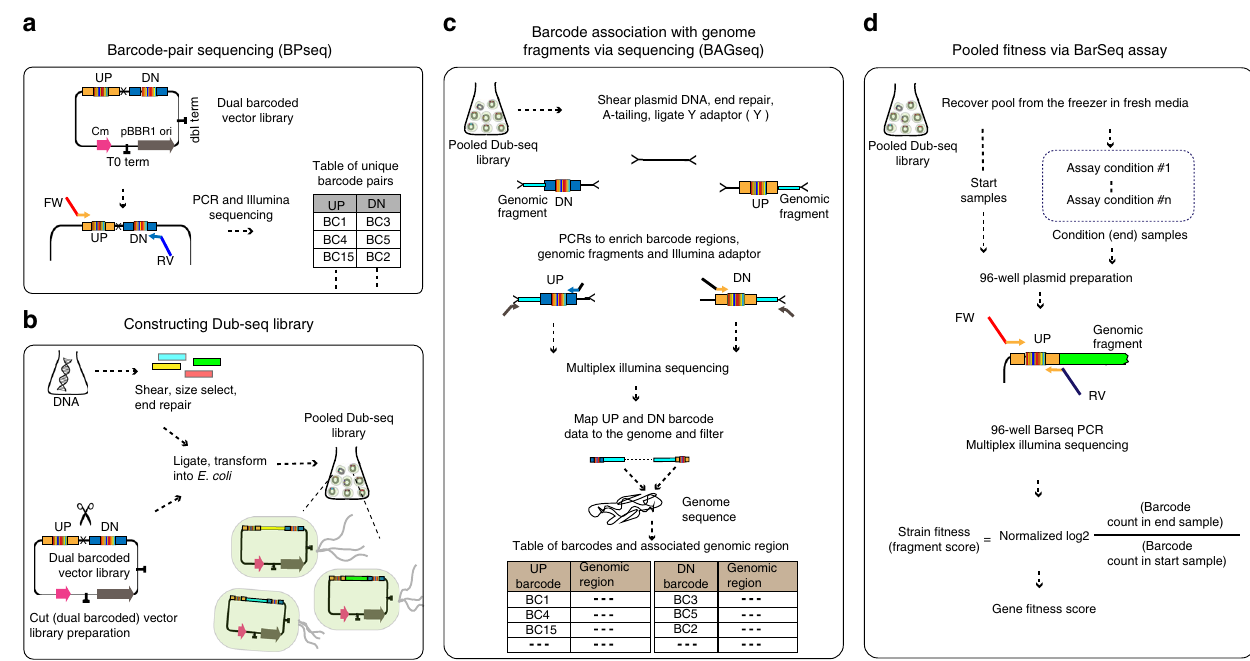
Fig. 1 Schematic overview of the dual-barcoded shotgun expression library sequencing (Dub-seq) approach. a A pair of random 20 nucleotide DNA sequences, the UP and DOWN (DN) barcodes are cloned into an expression vector. Deep sequencing of the dual-barcoded vector (BPseq) associates UP and DOWN barcode sequences. b Target genomic DNA is randomly sheared and cloned between the UP and DOWN barcodes to create the Dub-seq plasmid library. c To characterize the Dub-seq library, a “ Tn-seq ” like protocol is performed to precisely map the two genomic breakpoints of each insert and to associate each breakpoint with its random DNA barcode sequence. If the source genome(s) has been sequenced, then BAGseq can be used to de fi ne the exact sequence of each plasmid in the library. d The fi tness of bacteria carrying different plasmids can be measured with pooled growth assays and deep sequencing of the DNA barcodes (BarSeq). Strain (or fragment) fi tness is de fi ned as the log 2 ratio of barcode abundance after selection (end) versus before (start). Gene fi tness is estimated from the fragments ’ fi tness by a constrained